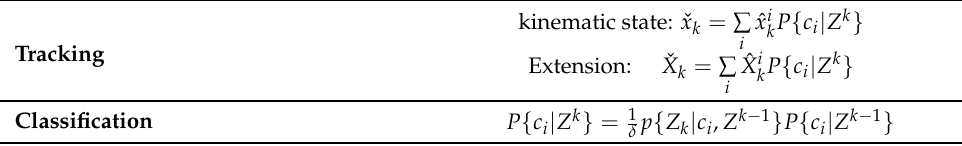
Table 1. EOT algorithm with embedded soft classification.